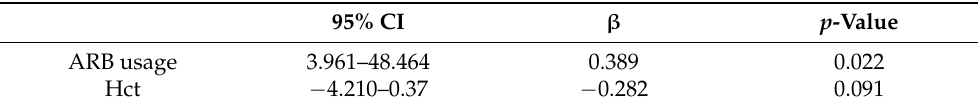
Table 6. Stepwise multiple regression analysis for independent determinants of maximal velocity of left